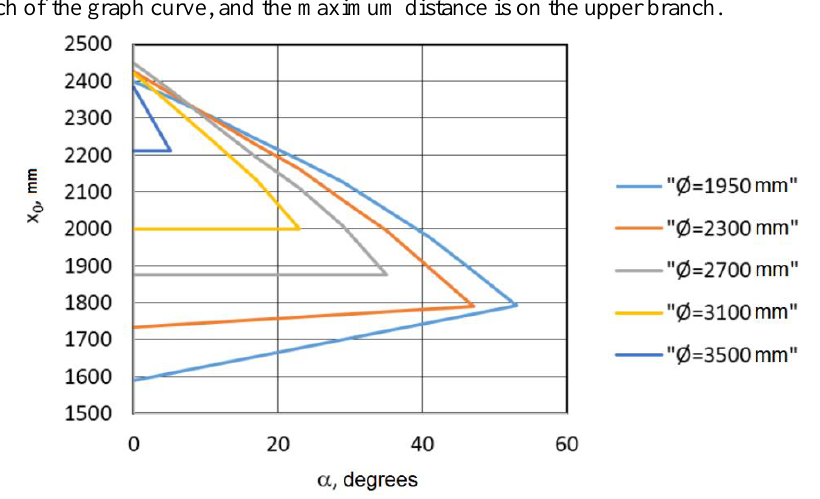
Fig. 13. Areas of possible location of the axis of rotation of the bottom and the axis of the robot at different angles of inclination for the bottoms of the petal division for different